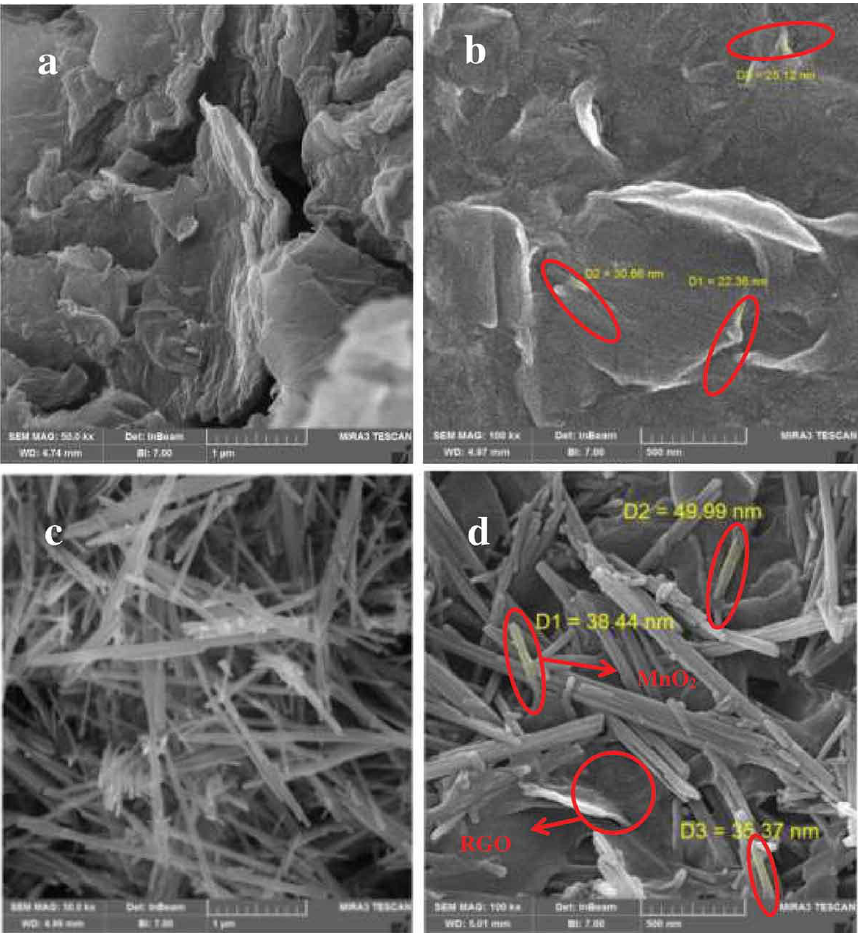
Figure 2. FE-SEM images of ( a ) graphene oxide (GO), ( b ) reduced graphene oxide (rGO), ( c ) α -MnO 2 , ( d ) α -MnO 2 /rGO nanocomposite (reproduced with permission from [81]; copyright 2019, Taylor & Francis